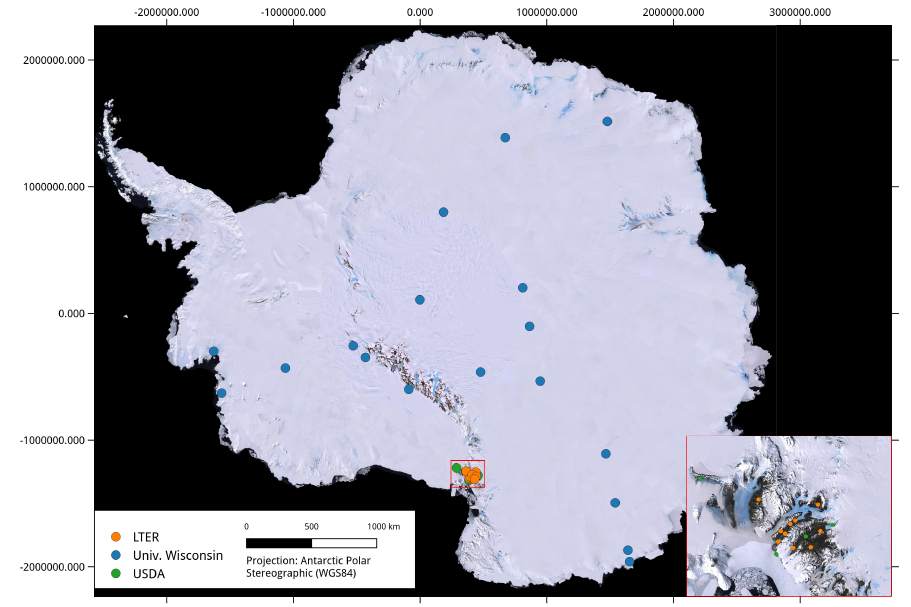
Figure 1. Map of weather stations used for model training and evaluation overlayed on a Landsat composite image [32]. The McMurdo Dry Valleys are shown in